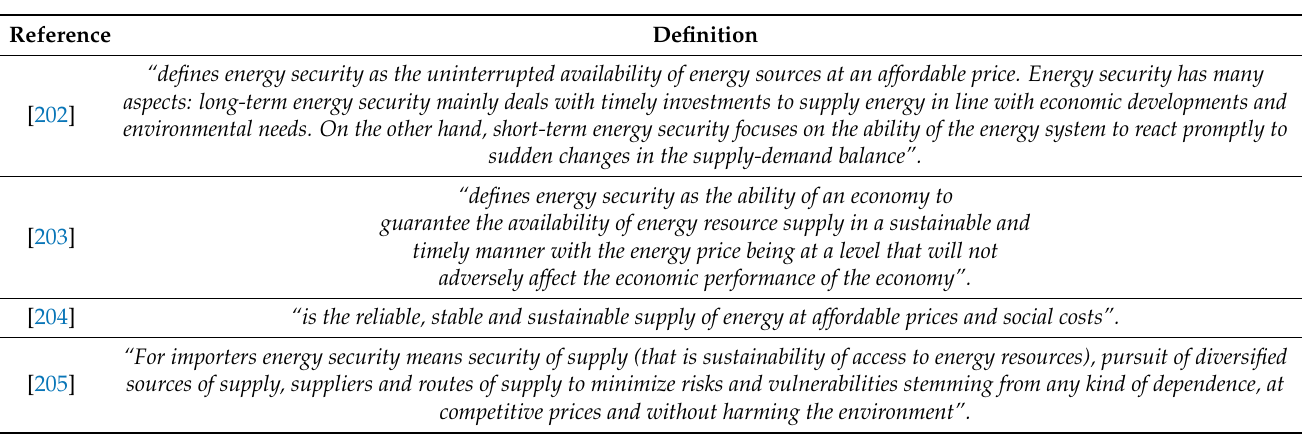
Table A2. Definitions of energy